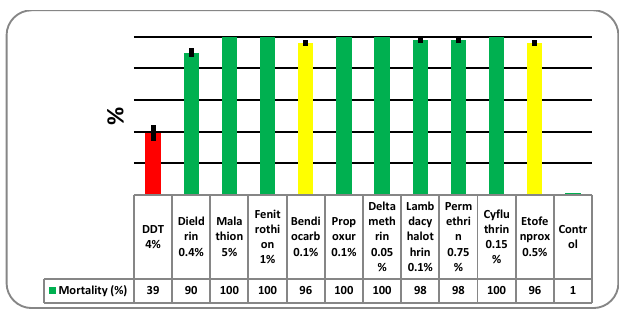
Figure 3: Susceptibility status of An. sacharovi to different insecticides in Parsabad County, Ardabil Province, Northwest of Iran, 1998